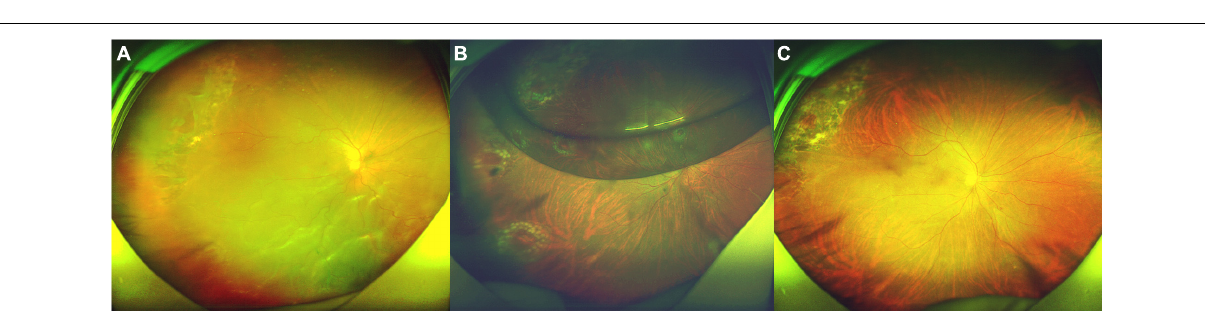
FIGURE 1 | Fundus photograph taken preoperatively and postoperatively of the patient (No. 15) undergoing 25-G PPV with air tamponade. (A) A total RRD (range: 12 clock hours) with an inferonasal horseshoe tear (2.5 PD) and posterior PVR. (B) Postoperative 6-day follow-up: the retina reattached. There was an air bubble in the vitreous cavity. (C) Postoperative 6-month follow-up: the retina reattached, with the firm chorioretinal adhesion induced by laser coagulation.